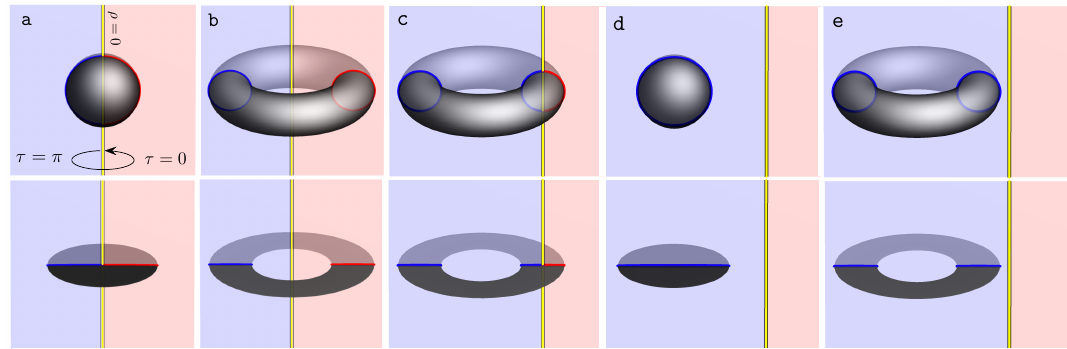
Figure 18 . Closed/open string contributions to the total Euclidean Rindler ( ds 2 = ρ 2 dτ 2 + dρ 2 + dx 2 ) partition function according to the picture of [57]. τ = angle around yellow axis ρ = 0 ; blue | red plane is τ = π | 0 . a,b,c contribute to the entropy. Sliced along Euclidean time τ , a and b can be viewed as free bulk resp. edge string thermal traces contributing positively to the entropy, while c can be viewed as an edge string emitting and reabsorbing a bulk string, contributing a (negative) interaction